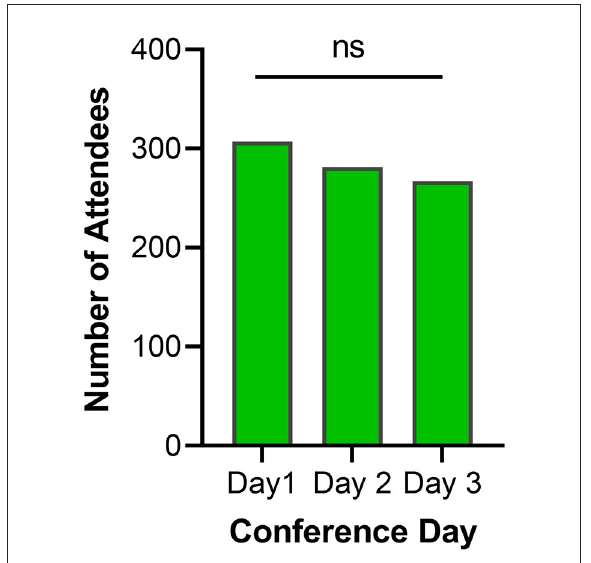
FIGURE1 Number of attendees across the three conference days. ns, not significant represents a p -value > 0.05. Statistical analysis by Chi square goodness-of-fit test, p = 0.2477, χ 2 = 2.791.